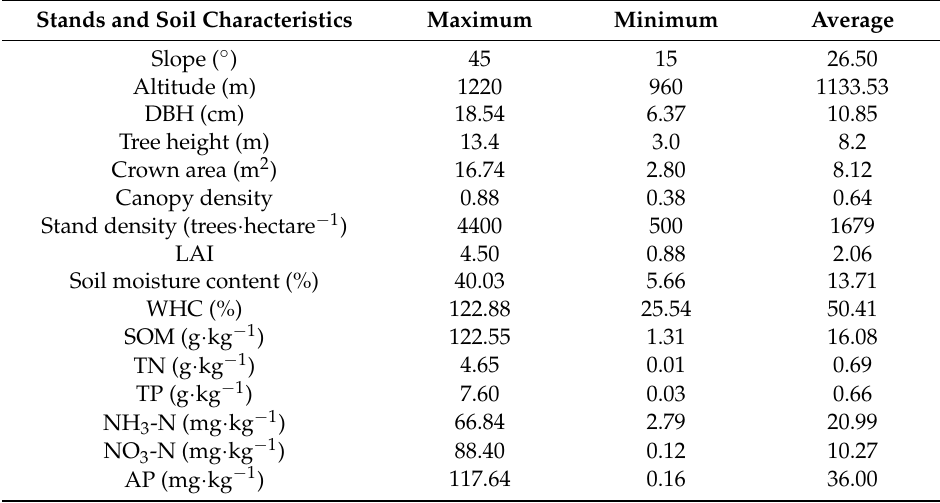
Table 2. The survey of the species of Robinia pseudoacacia L. and Pinus tabulaeformis Carr. mixed plantations in the Caijiachuan Watershed, Shanxi Province, West China. DBH, diameter at breast height; LAI, leaf area index; WHC, water holding capacity; SOM, soil organic matter; TN, total nitrogen;